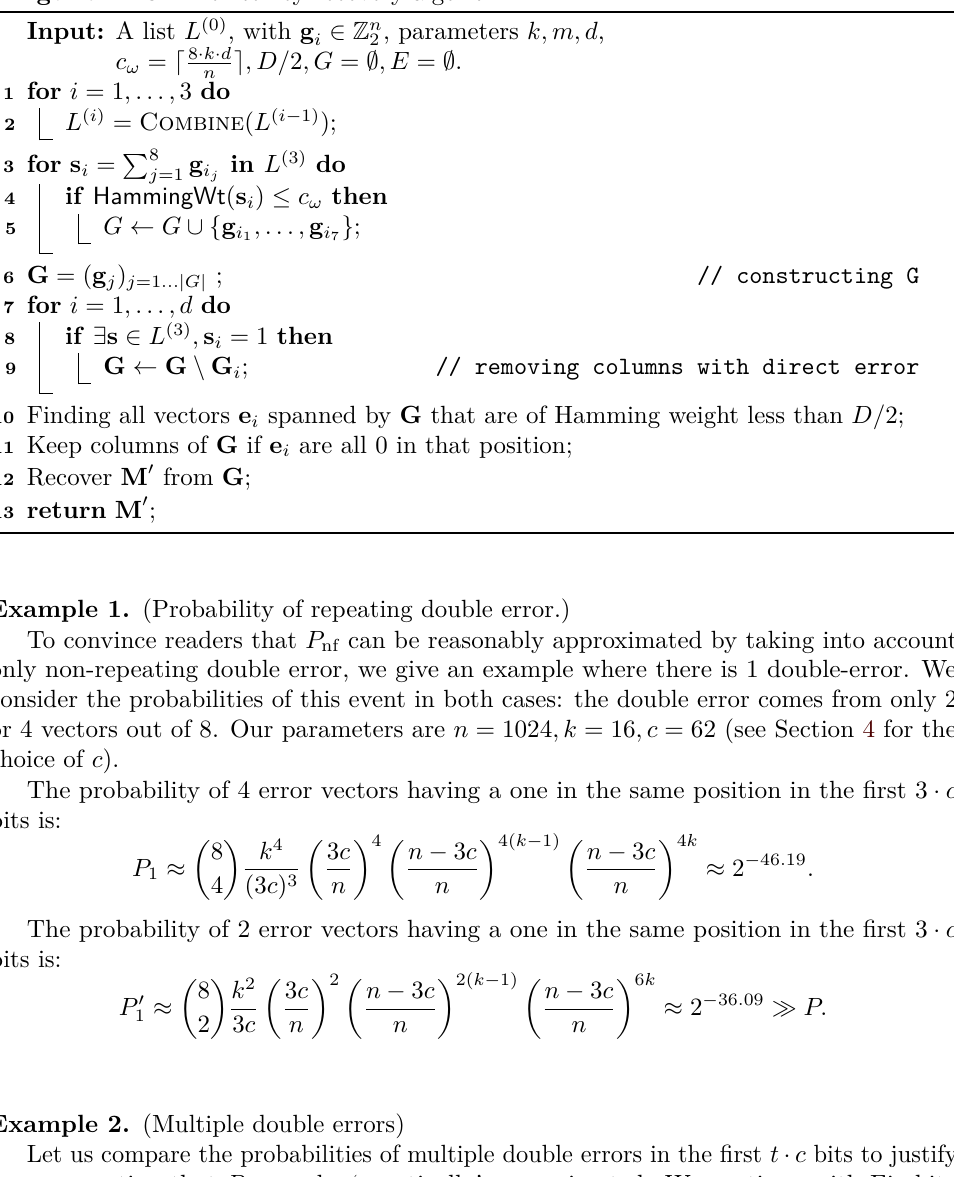
Algorithm 3: Firekite key recovery